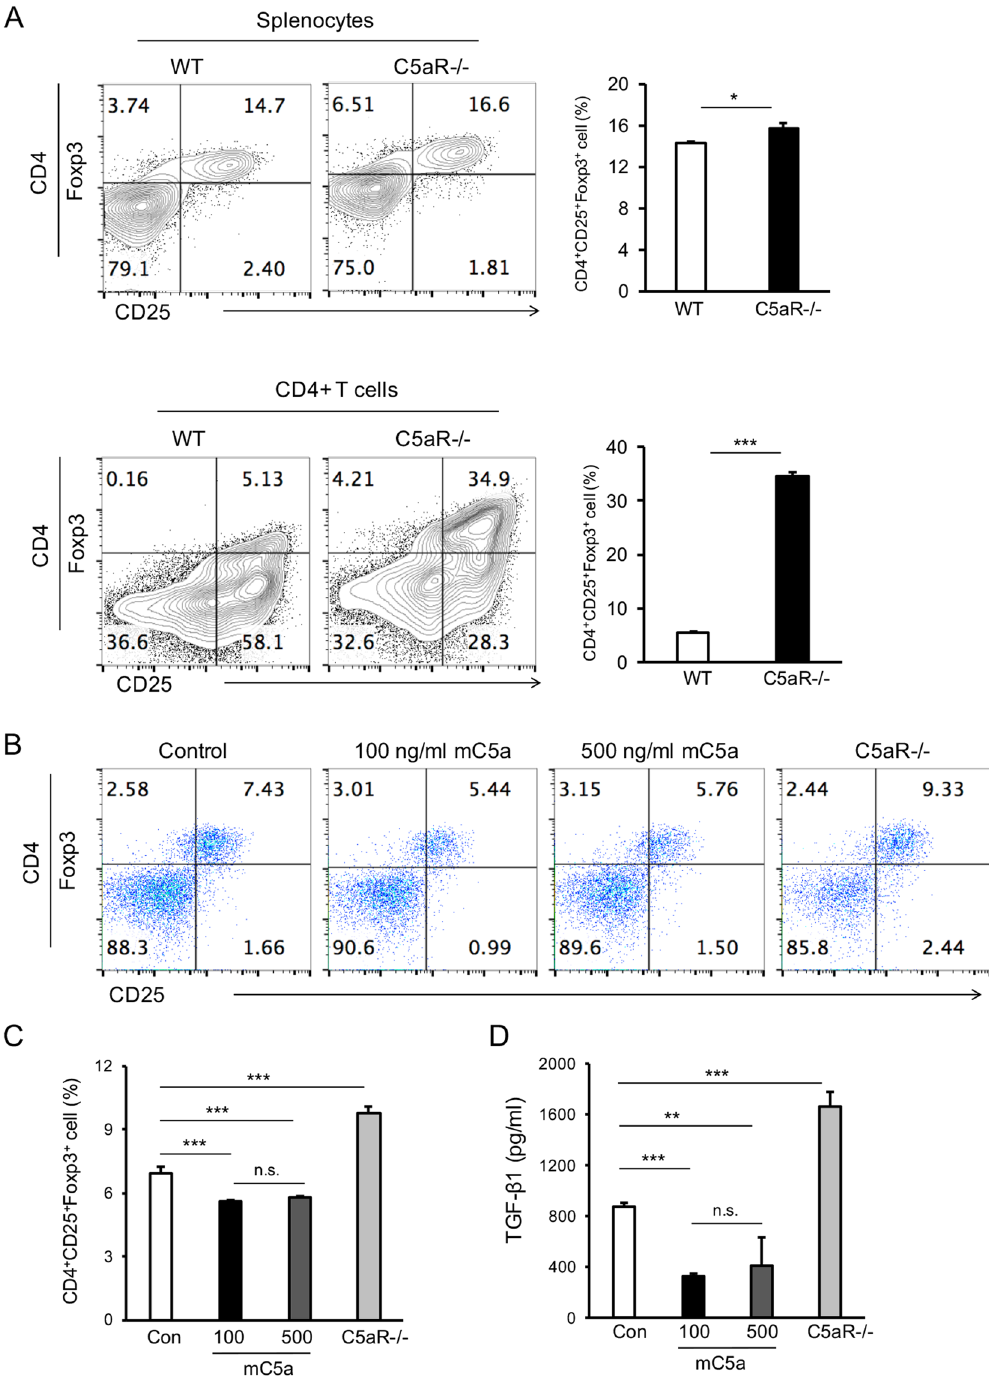
Figure 2. C5aR deficiency promoted the development of Treg, whereas C5a activation abolished the occurrence of Treg cell in vitro . ( A , upper panel) Splenocytes from the C5aR deficient mice and WT mice were isolated and analyzed directly for the frequency of Treg. Representative flow cytometry plots showed CD25 and Foxp3 expression in CD4 + cells. ( A , lower panel) CD4 + T cells from the C5aR deficient mice and WT mice were sorted and stimulated in the Treg polarization condition. Representative flow cytometry plots showed CD25 and Foxp3 expression in sorted CD4 + cells from WT and C5aR − / − mice. ( B , C ) The cultured splenocytes were stimulated with anti-CD3 and anti-CD28 antibodies for 3 days. The frequency of Treg was reduced in response to 100 ng/ml or 500 ng/ml mC5a stimulation. However, the splenocytes from the C5aR-deficient mice were activated and inclined to differentiate toward CD4 + CD25 + Foxp3 + Treg. ( D ) The supernatant protein level of TGF- β 1 was decreased in the mC5a stimulation group, whereas it was significantly increased in the C5aR − / − splenocytes. At least five mice were used in flow cytometry experiment (N = 5) and there were at least three cell samples (N = 3) in ( B–D ); n.s. = no significance, * p < 0.05, ** p < 0.005, *** p <